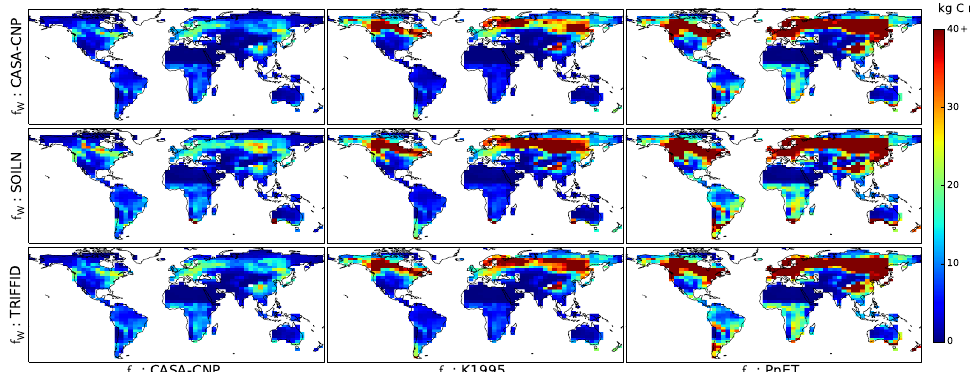
Fig. 5. Soil C density at equilibration in 1850 in CN